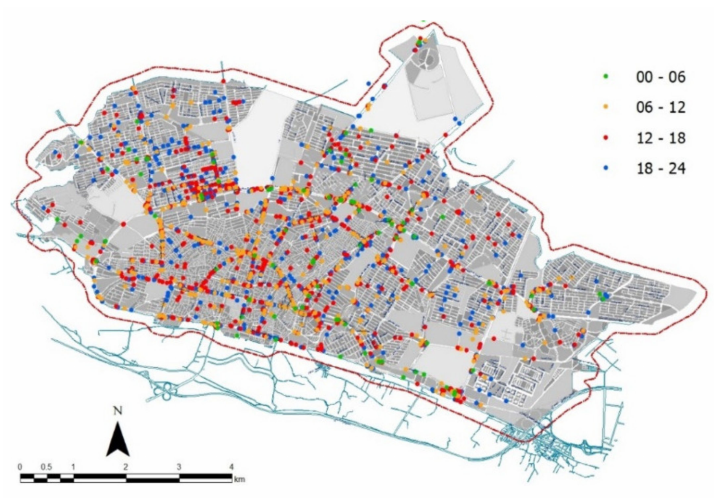
Figure 3. Map of road accidents in Zanjan city by time of the day including four classes that cover 6 h each, namely night (00–06), morning (06–12), afternoon (12–18) and evening